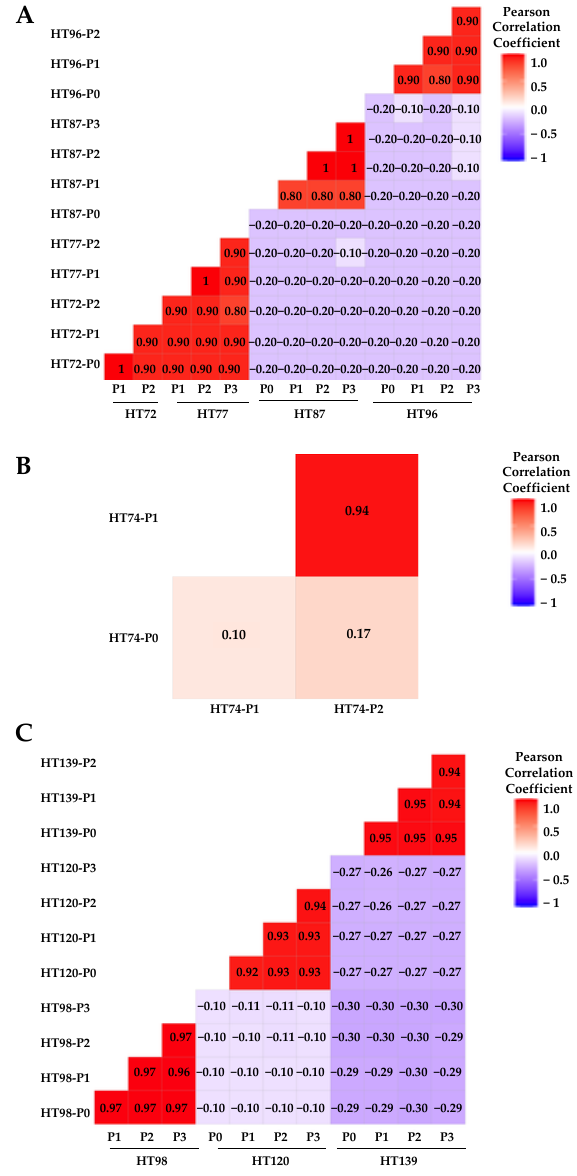
Figure 6. SNVs were preserved between P0 and their respective passaged PDXs and among the PDX of each tumor cohort. PPCC score was calculated for SNV profiles in all genes between original tumors and their corresponding PDX passages for ( A ) OS PDXs HT72, HT77, HT87, HT96, ( B ) RMS PDX HT74, and ( C ) PDXs for Wilms Tumors HT98, HT120, and HT139. In P0 tumors and their respective passaged PDXs, most of the SNVs in P0 (Figure 7) were preserved in successive PDX passages. UpSet plots demonstrate intersections of SNVs that are the same between the P0 and its subsequent PDX passages. For example, in HT72, 87.4% of SNVs are common between P0, P1, and P2 (Figure 7A), whereas HT77 illustrates 88.9% common SNVs among P0, P1, P2, and P3 (Figure 7B). In HT87 and HT96, 78.4% (Figure 7C) and 76.8% (Figure 7D) SNVs, respectively, are commonly found between P0 and their subsequent passages. Similarly, RMS PDX HT74 also has about 76.9% SNVs occurring between the P0, P1, and P2 (Figure 7E). For Wilms tumors, SNVs that are commonly occurring between P0 and their respective passages are all > 90% (HT98 = 94.7%, HT120 = 91.9%, HT139 = 96.3%; Figure 7F,H). In addition, there were small numbers of SNVs that were only found in subsets of a particular cohort (Figure